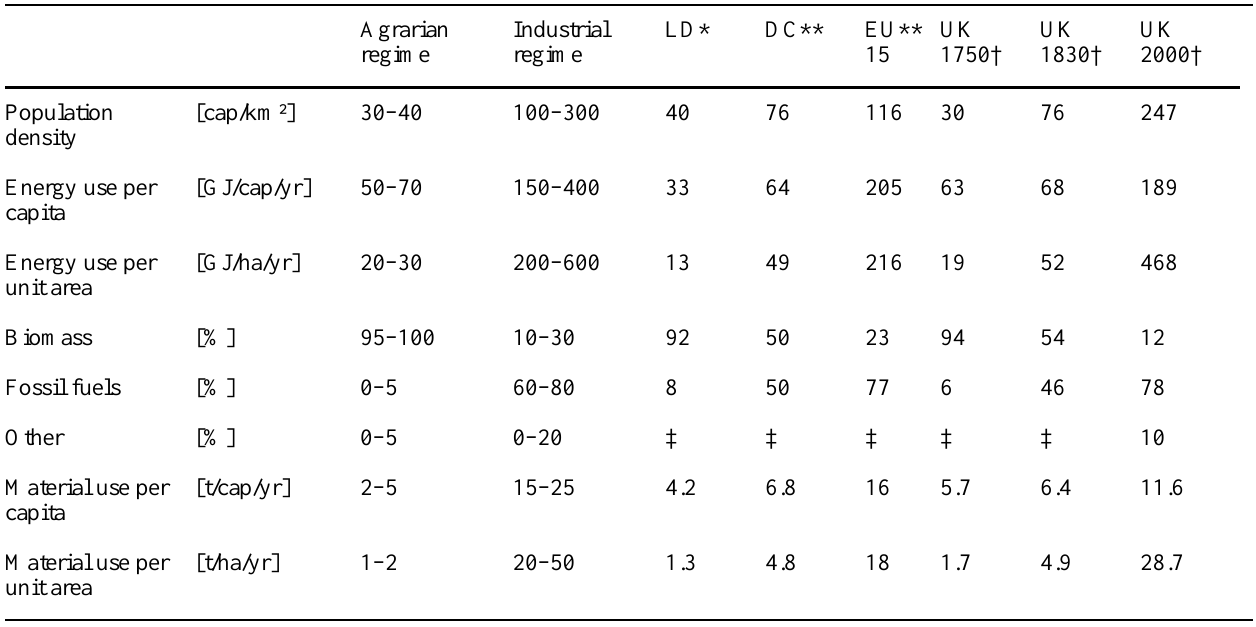
Table 2. Metabolic profiles of the agrarian and industrial socioecological regimes. Agrarian